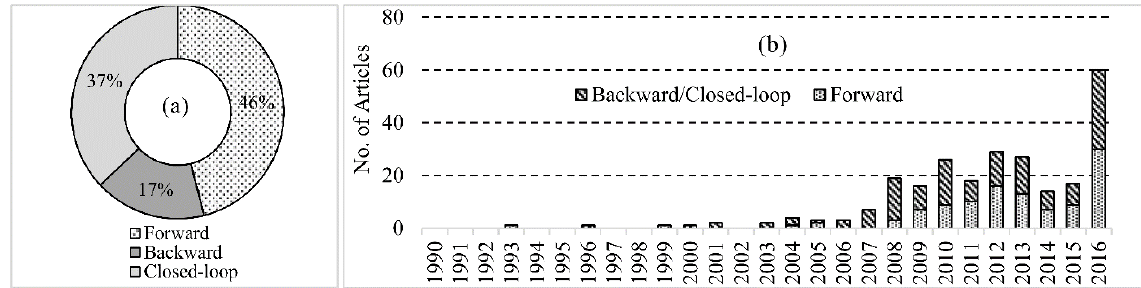
Figure 5. Portion of forward, reverse and closed-loop supply chains in the reviewed articles and their frequencies in desired horizon Sustainability